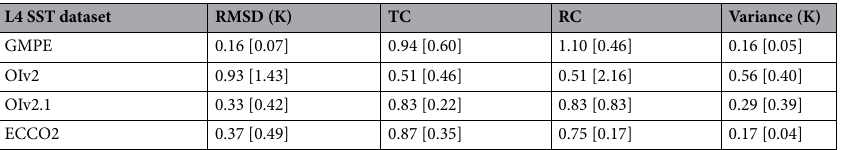
Table 1. The root mean squared difference (RMSD), time correlation (TC), regression coefficient (RC), and variance of GMPE, OIv2, OIv2.1, and ECCO2 with respect to the Sumatra buoy (5° S, 100° E) averaged for 6